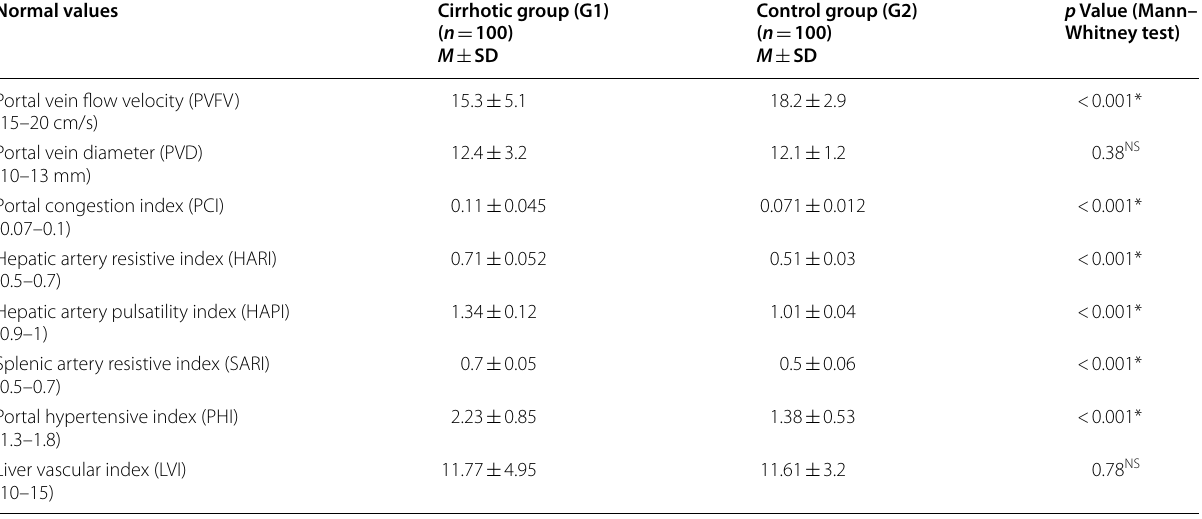
Table 4 Comparison of portal vein diameter and different hemodynamic indices by B‑mode and color Doppler US between cirrhotic group and control group